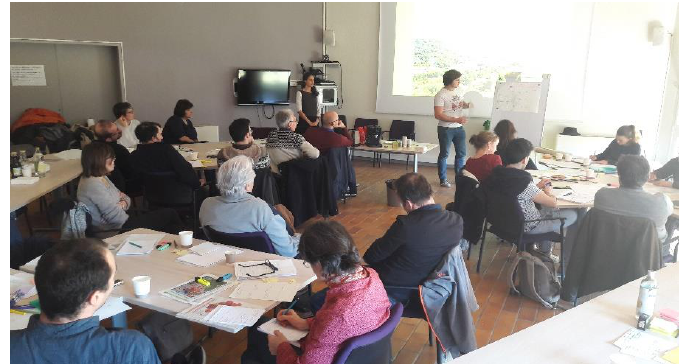
Figure 2. The Territory Game workshop during the restitution phase.